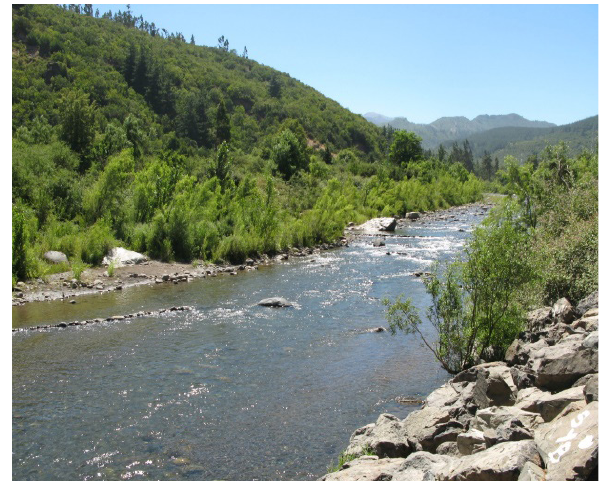
Figure 2. Substrate heterogeneity on the riverbanks: always sand, but also gravels and rocks. Rio Claro, Tinguiririca tributary, O’Higgins region (34° 44′ S). Subhumid mesomediterranean thermotype.